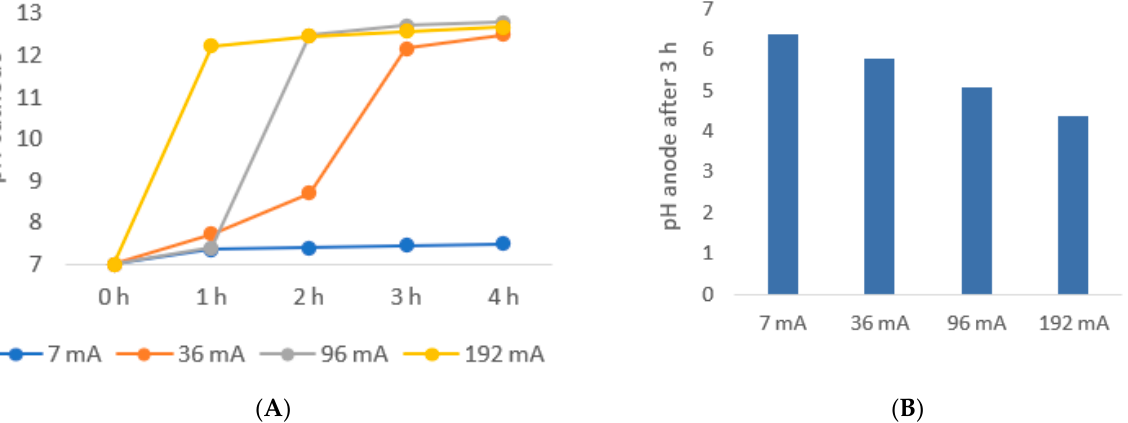
Figure 9 . Relationship between ( A ) current and voltage for the examined system at the maximum voltage interval allowed by the potentiometer TTi and ( B ) extraction rate of succinic acid as a function of current during five different 3 h experiments. For both experiments the initial concentration of succinic acid in the cathode chamber was 50 g L − 1 and the initial concentration in the anode chamber was of 5 g L − 1 .